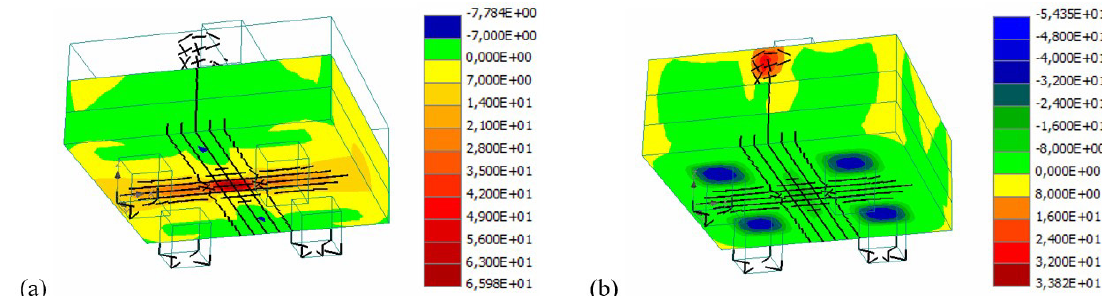
Figure 16. Numerical model